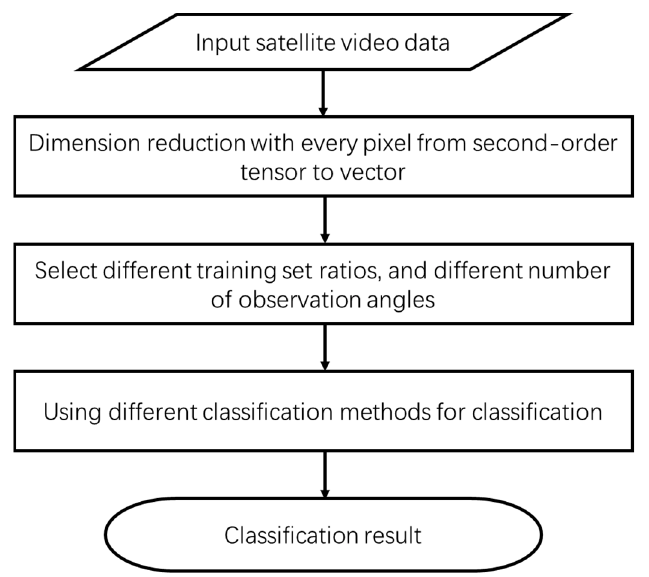
Figure 2. Main flow chart of the experimental methods.